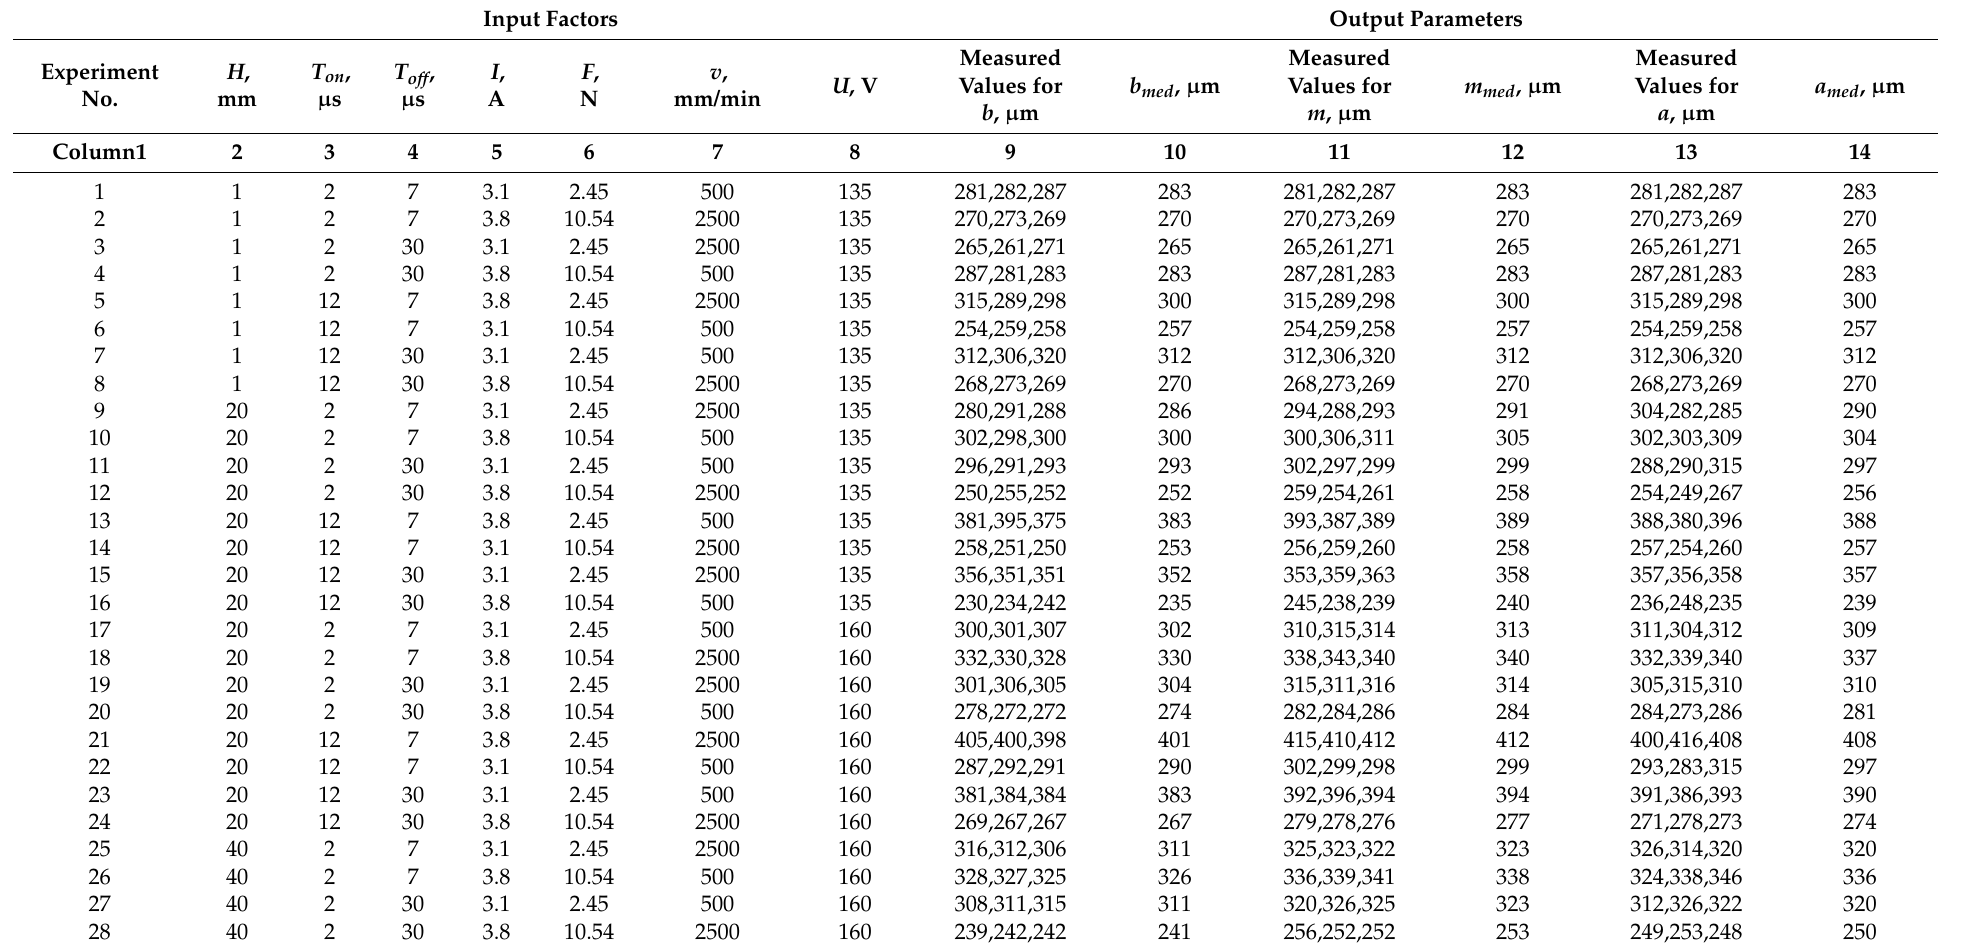
Table 1. Experimental conditions and